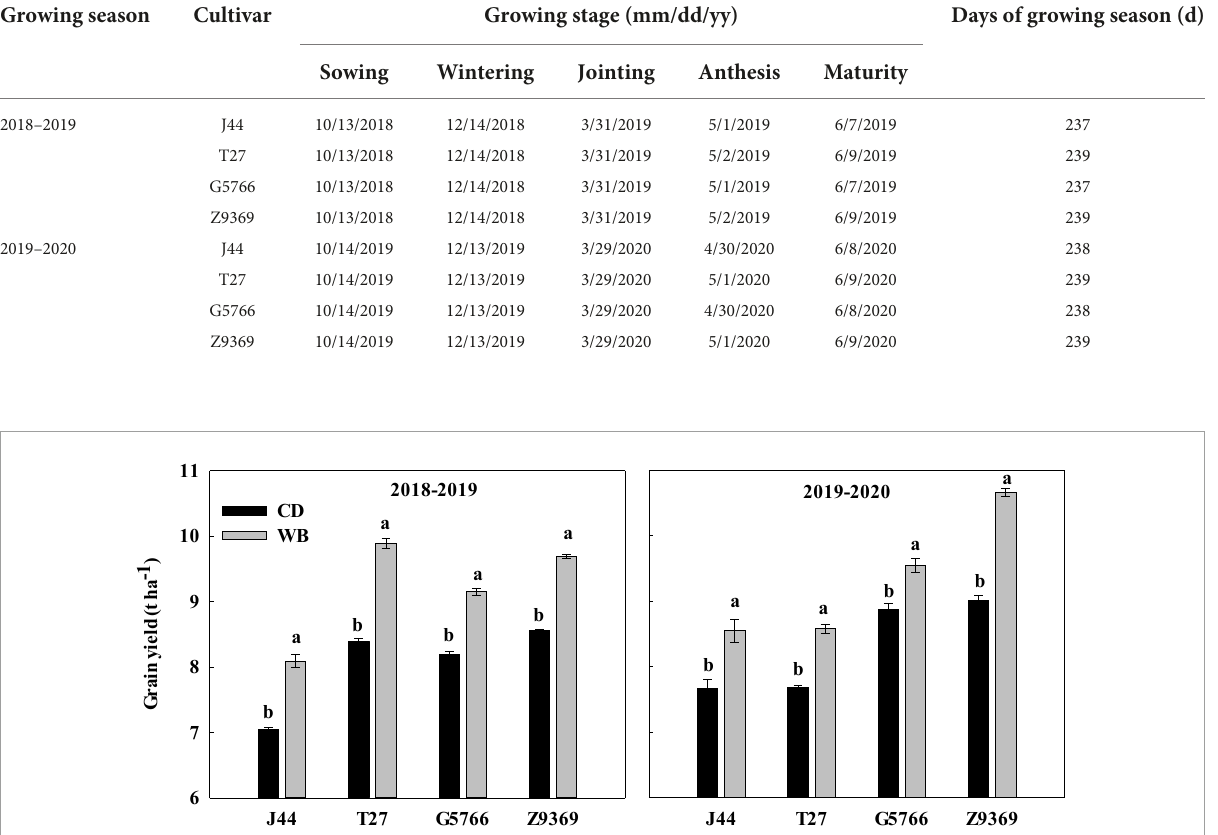
FIGURE3 Effects of sowing pattern on the grain yield of bread wheat. Values are means of three replicates per treatment. Vertical bars indicate standard error. Different letters in the same season and cultivar indicate a significant difference at P < 0.05, as determined by the LSD test. CD and WB denote the conventional drilling and wide belt sowing pattern,